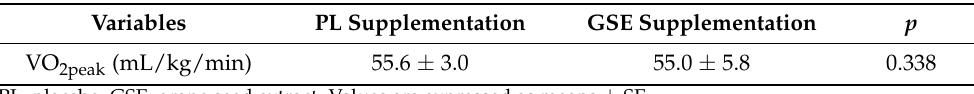
Table 2. Maximum oxygen consumption after PL and GSE